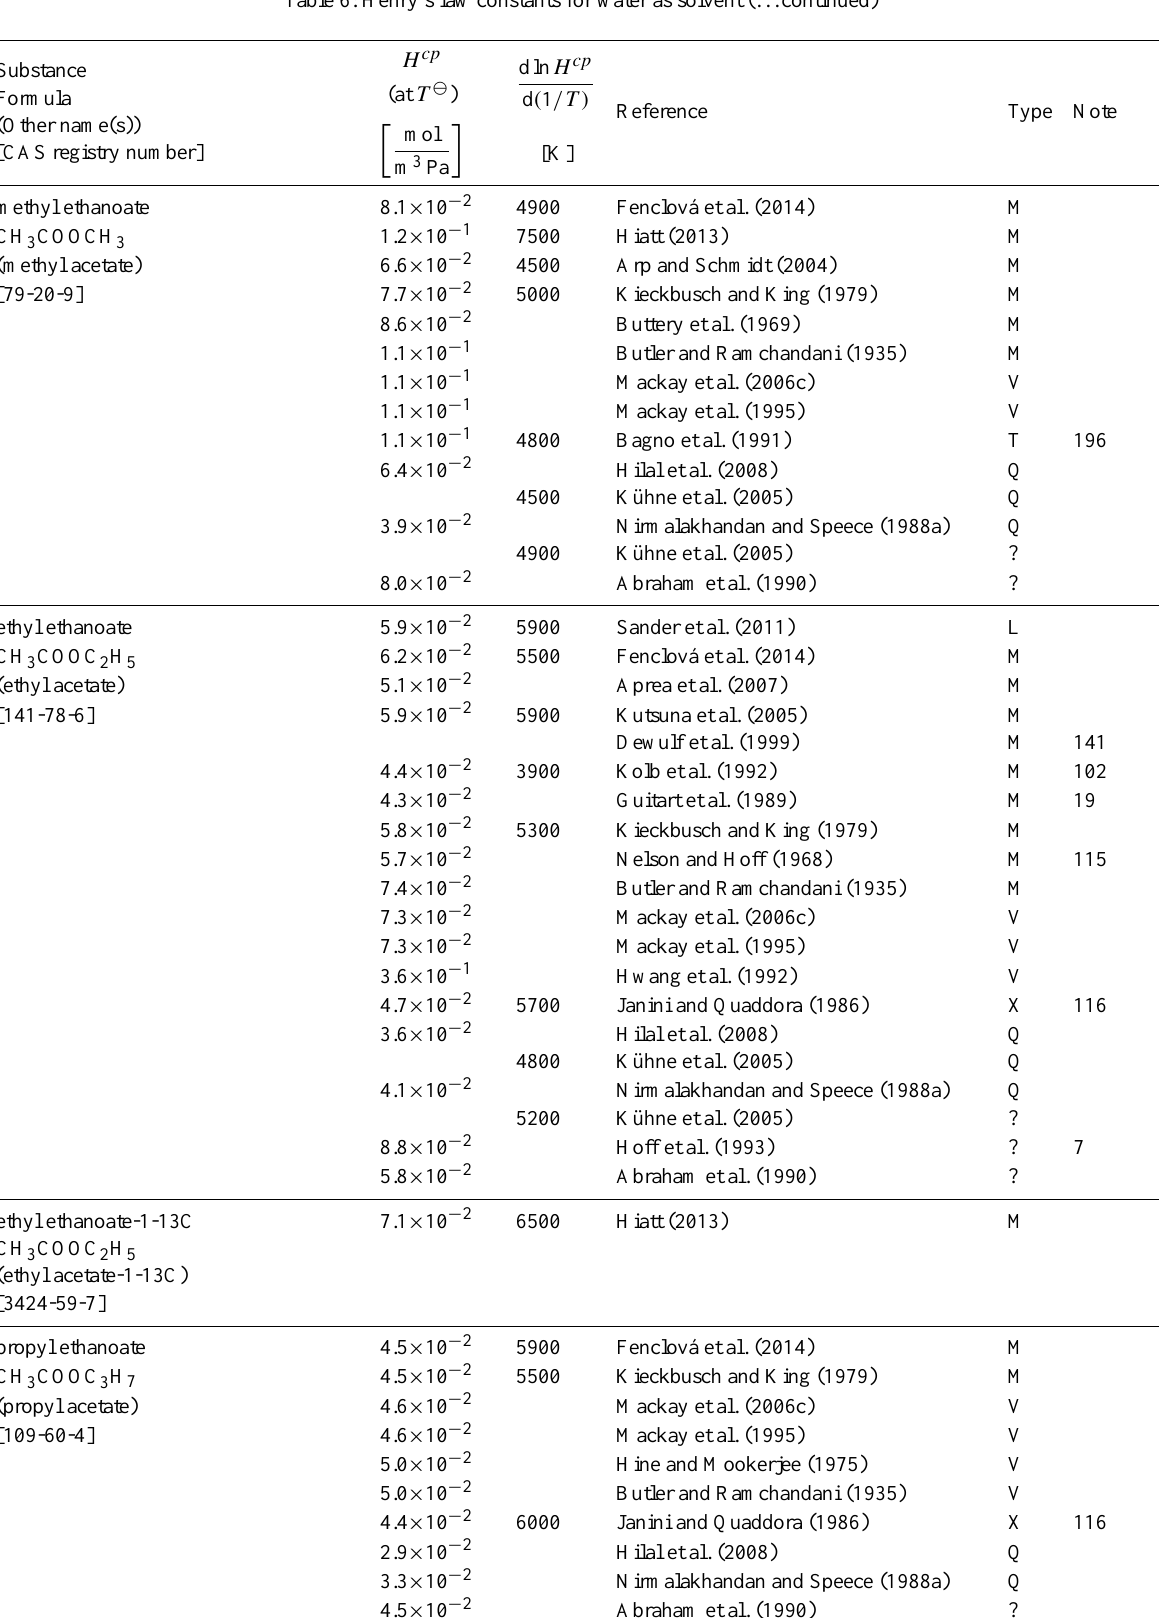
Table 6: Henry’s law constants for water as solvent